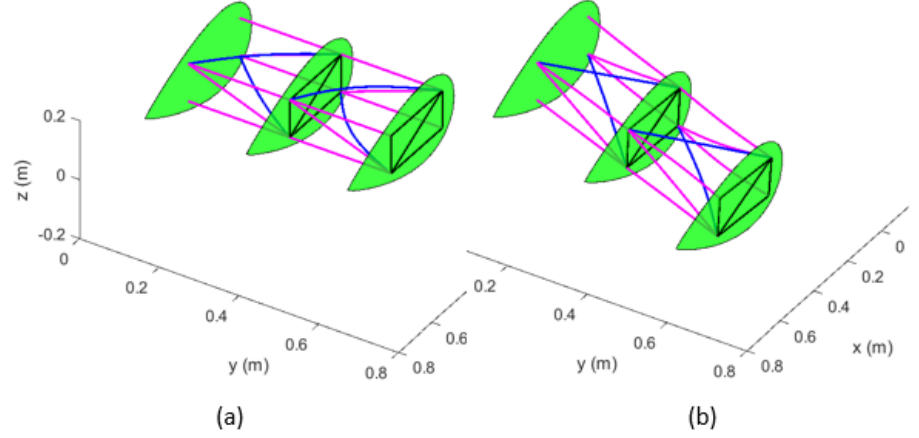
Figure 14. Sixth mode shape for the system in the ( a ) un–morphed configuration, ( b ) morphed configuration (simulation 25).